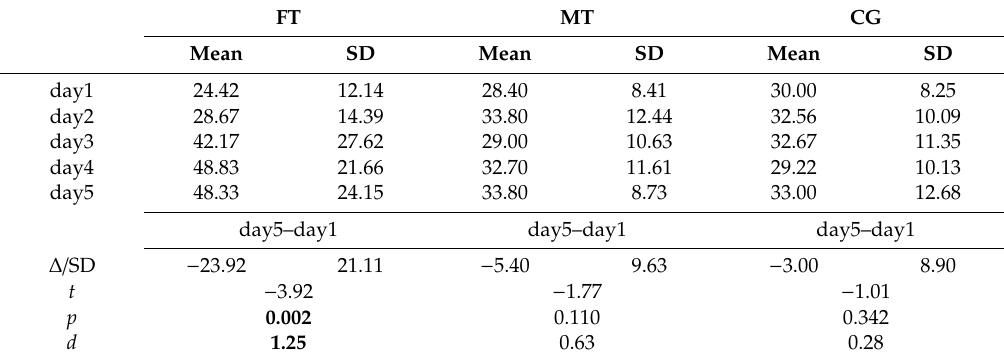
Table A7. Mean values and e ff ect sizes for Deck D within